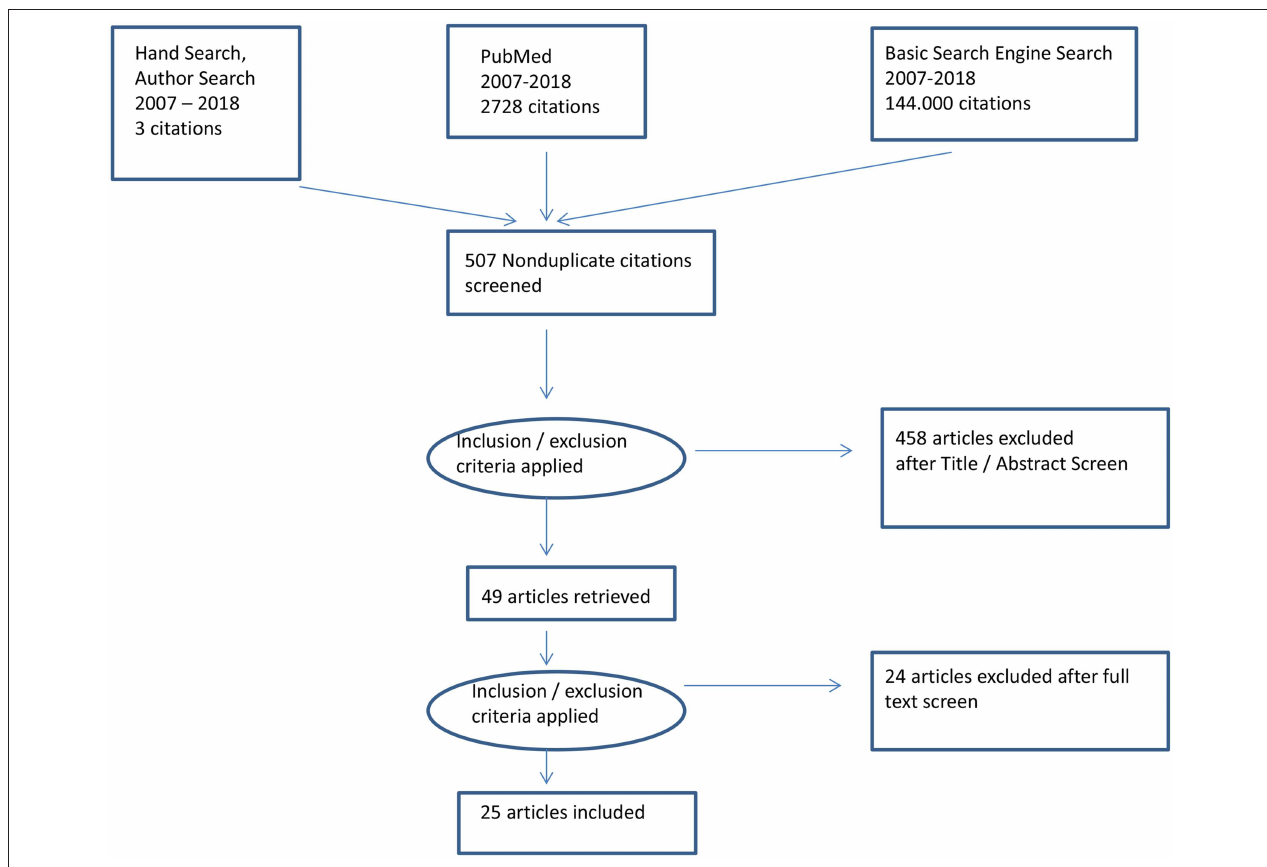
FIGURE 1 | PRISMA diagram of the search